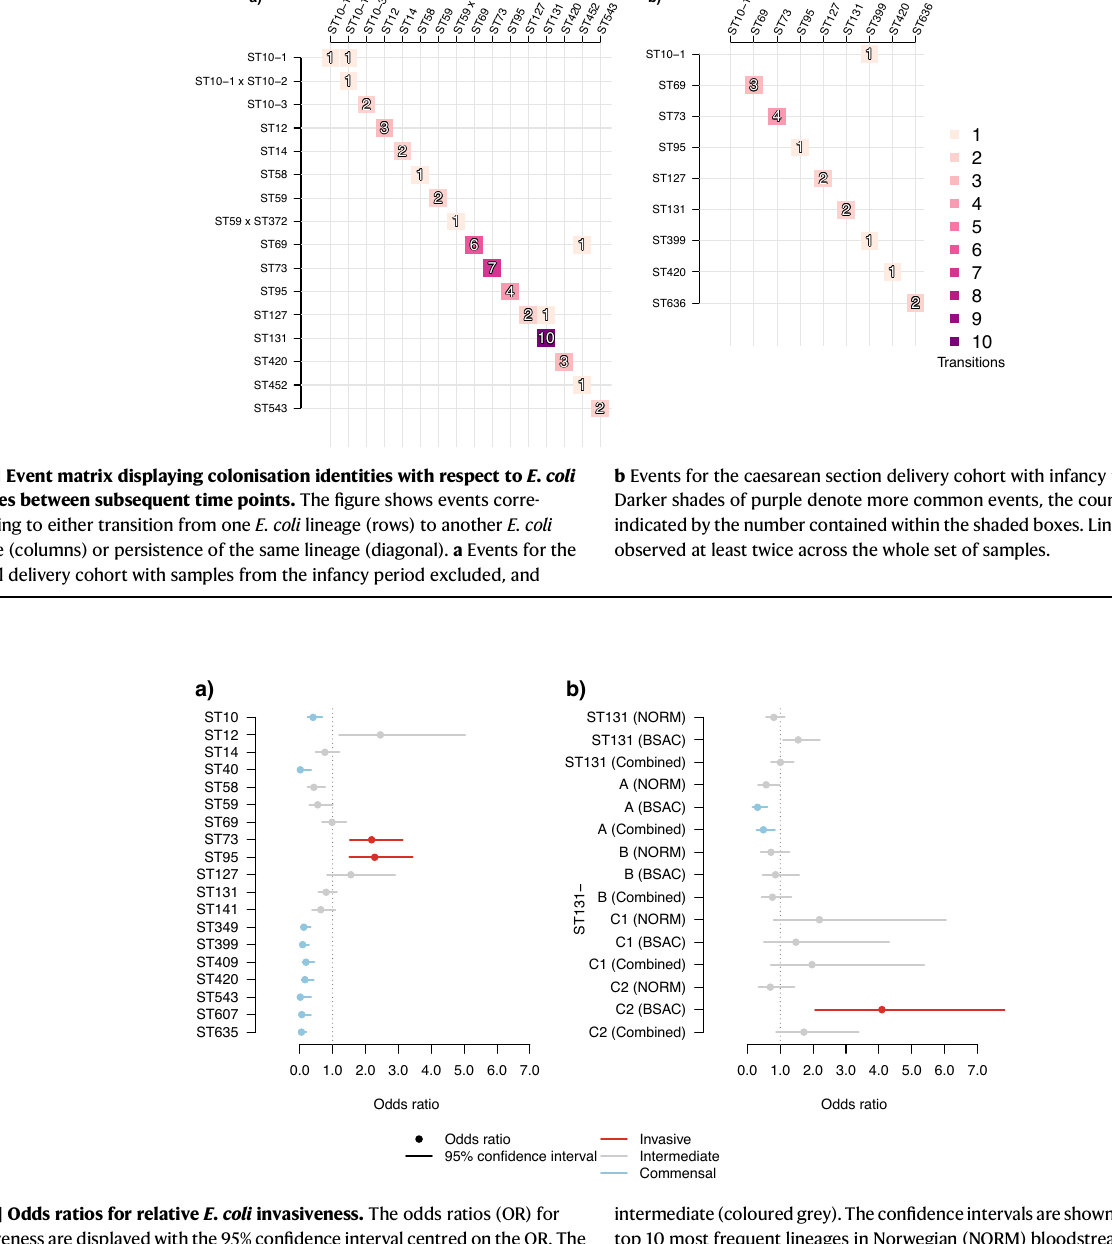
intermediate(colouredgrey).Thecon fi denceintervalsareshownin( a )forboththe top 10 most frequent lineages in Norwegian (NORM) bloodstream infections (STs 10, 12,14, 59, 69, 73, 95,127, 131, and 141) and all additional lineages, where the OR was estimated to differ from 1 (signi fi cantly or not). b The con fi dence intervals estimatedforbothST131asawholeandadditionallyforitsestablishedsublineages (ST131 A, B, C1, and C2). For both ST131 and the subclades, the estimates are reported using either the BSAC (UK) collection, the NORM (Norway) collection, or combined collections for comparison. The exact p-values and the sample sizes are available in the Source Data fi le for this fi gure.